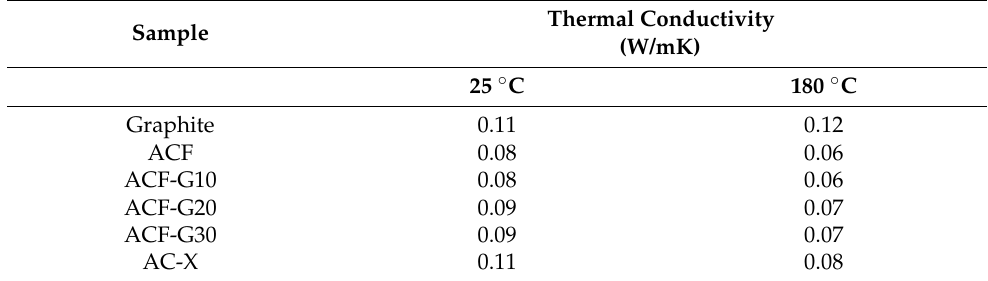
Table 2. Thermal conductivity of the carbon catalysts.